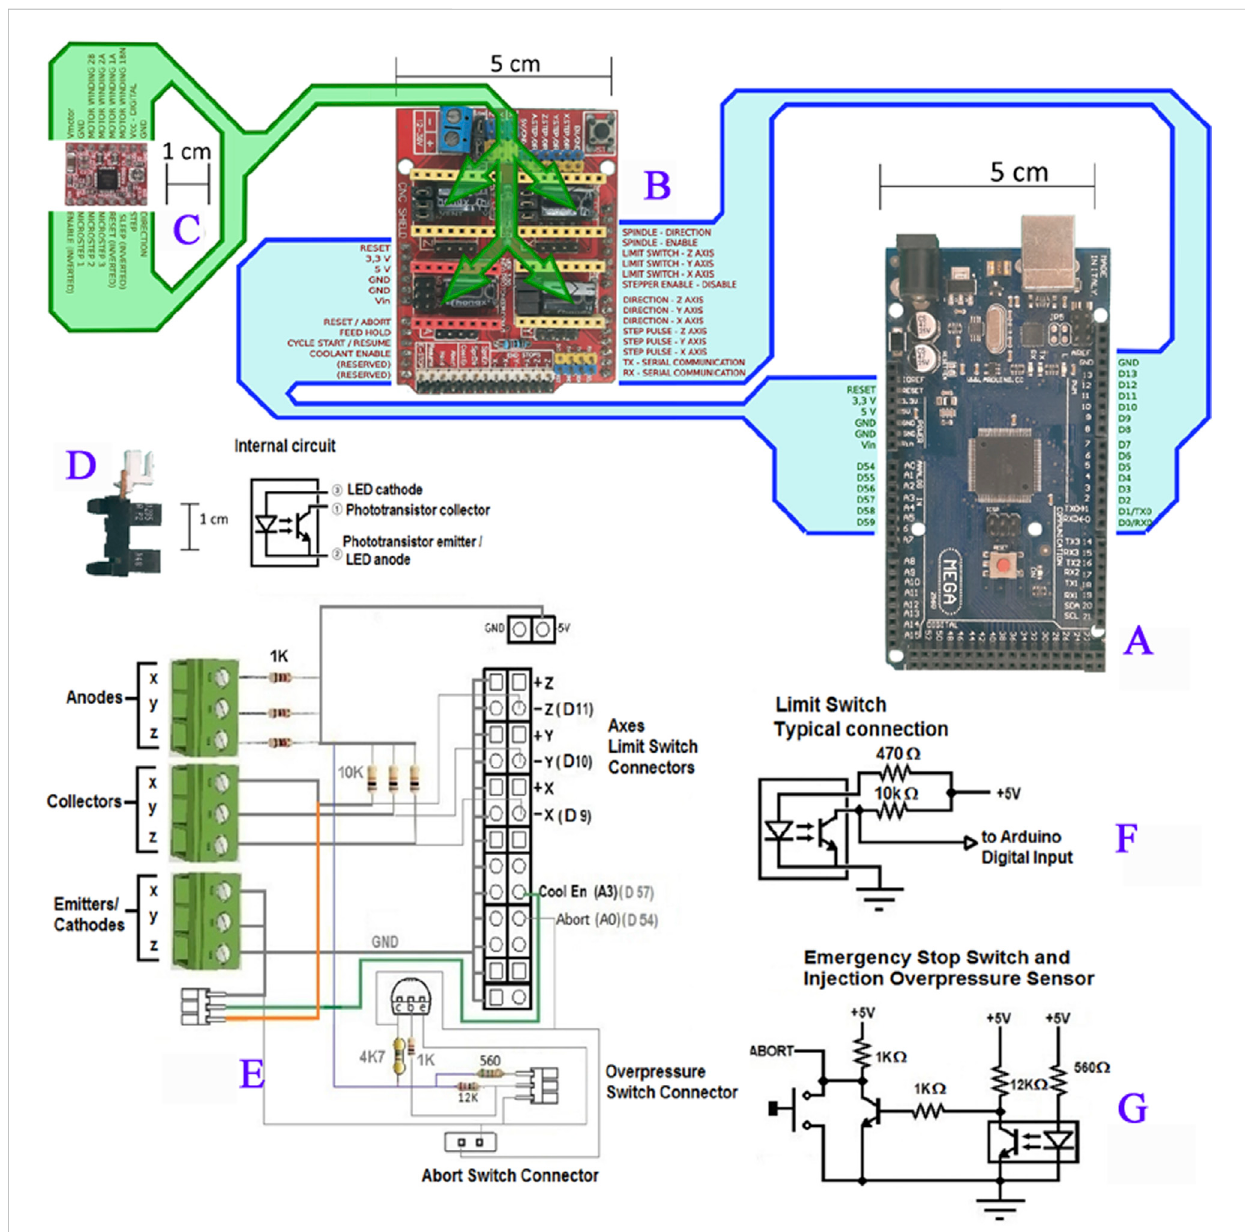
FIGURE 6 Prototype electronic components. (A) Arduino Mega 2560 board, with the respective pin out identi fi cation (id. absent for unused pins). (B) CNC Shield board for Arduino Uno/Mega, with the function name of the pins in the same respective order of the corresponding pins in the Arduino. (C) Stepping motor Allegro A4988driver module, with the corresponding functional pin identi fi cations. (D) Transmissive photomicrosensor OMRON EE- SX1235A-P2 used as thelimit switch. Left:side vision of thephotomicroswitch, where theblock inthe upperrightpart ofthe picture, above thegap, is the phototransistor and the block in the lower right is the LED. Right: Schematic diagram of the sensor. (E) Wiring layout drawing of the limit switch connections. (F) Typical photosensor connection as the limit switch, used for the X, Y, and Z-axes and for the Injector (named “ A axis ” in the CNC board labels). (G) Circuit schematic of the overpressure sensor and Emergency Stop